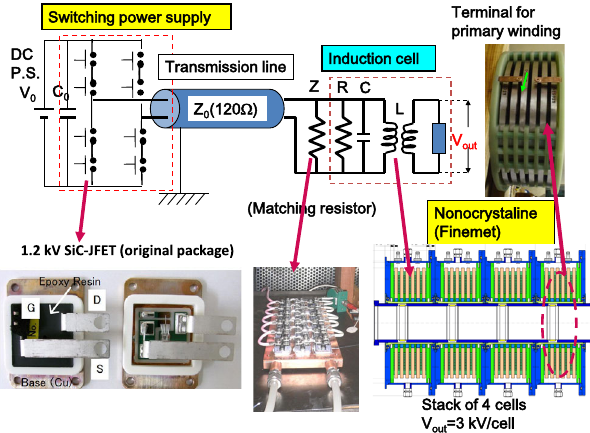
FIG. 6. Equivalent circuit of the induction acceleration cell and their key